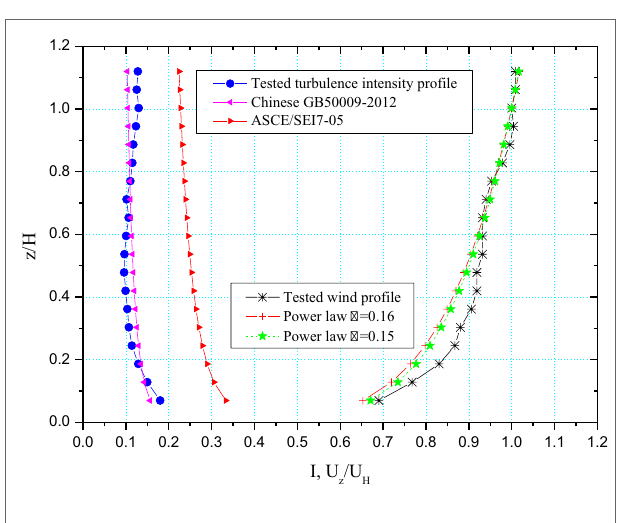
FigUre 6 | Wind profile and turbulence intensity .